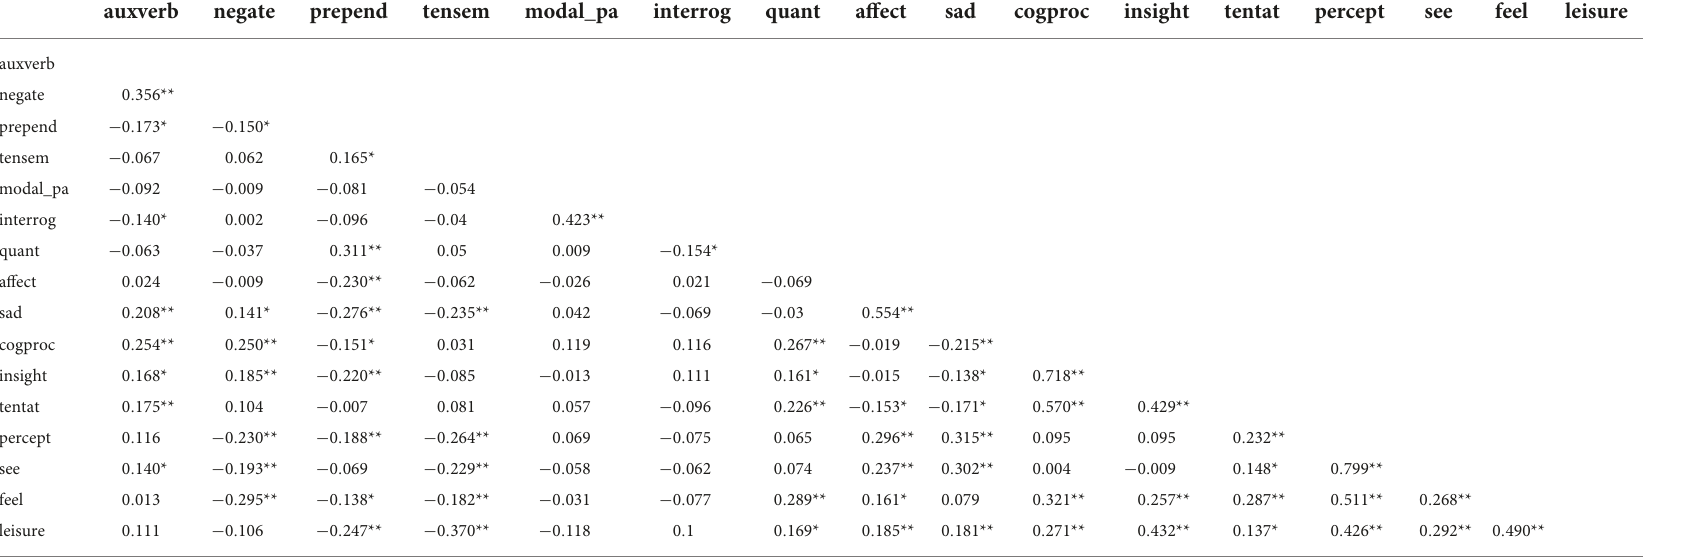
TABLE 2 Correlation matrix of the 16 categories of